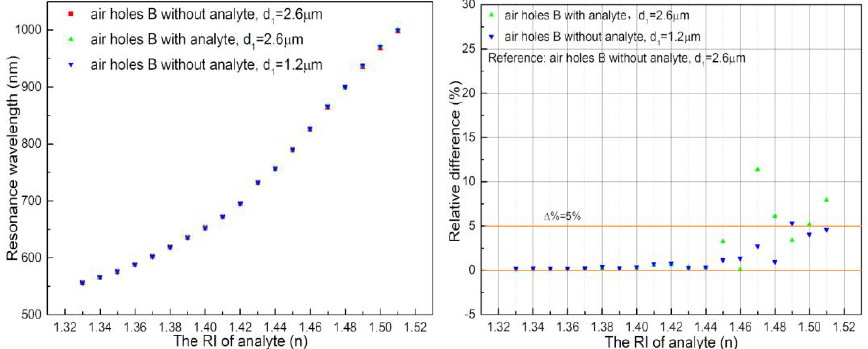
Figure 6. ( Left ): Scatter plot of the RI wavelength with B holes under different conditions; ( Right ): relative difference of the loss peak with B holes under different conditions.